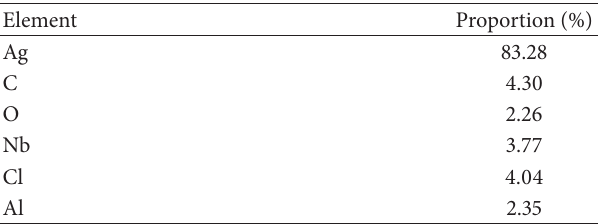
Table 1: Nanosilver, EDX analysis of element